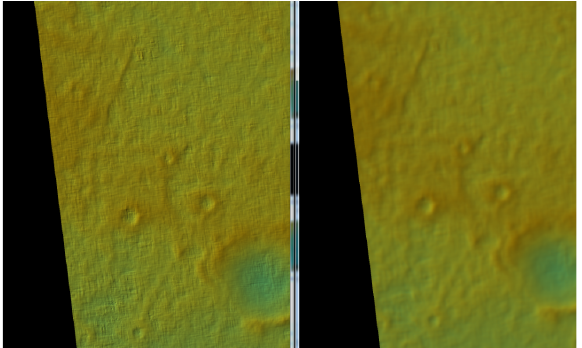
Figure 3. An example of the MER-A DTM, showing quilting artefact from ASP processing (left) and DTM after initial disparity refinement in CASP-GO